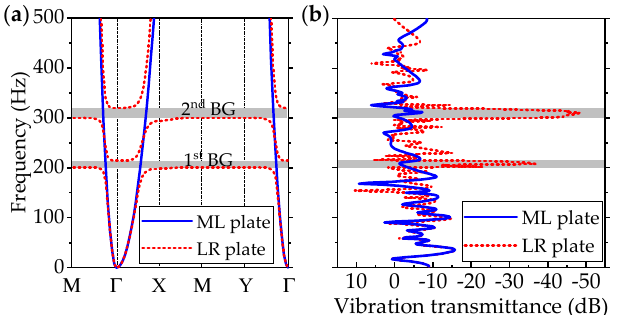
Figure 7. ( a ) Band structures of the infinite mass-loaded (ML) plate and locally resonant (LR) plate, and ( b ) the vibration transmittances of their finite counterparts with fully free boundary conditions.